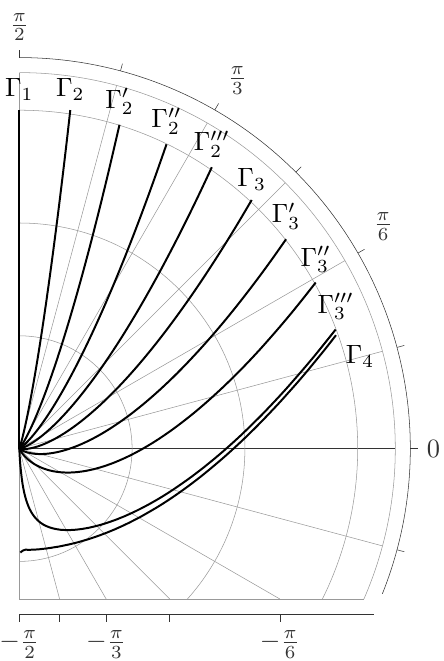
( 0,1 ) and various values of parameter θ . The contours are given ∈ 1, Γ 2 - θ = 0.75, Γ (cid:48) - θ = 0.5, Γ (cid:48)(cid:48) - θ = 0.25, Γ (cid:48)(cid:48)(cid:48) - θ = 0, Γ 3 - θ = 0.25, 2 2 2 − − − − Γ Γ (cid:48)(cid:48)(cid:48) 3 - θ = 0.98, 4 - θ = 1. π 2